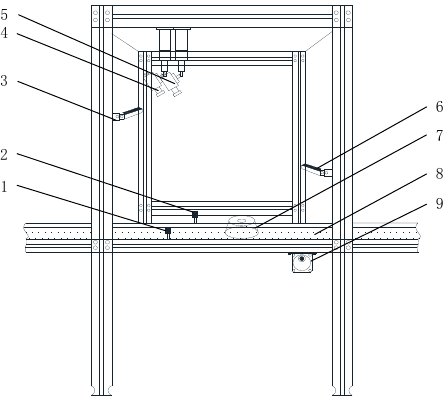
Figure 1. Image acquisition device: (1) photoelectric sensor transmitter; (2) photoelectric sensor receiver; (3) top light source in front of the cone yarn; (4) industrial camera on the top left of the cone yarn; (5) industrial camera on the top right of cone yarn; (6) upper light source behind the cone yarn; (7) cone yarn; (8) cone yarn conveying channel; (9) servo motor.